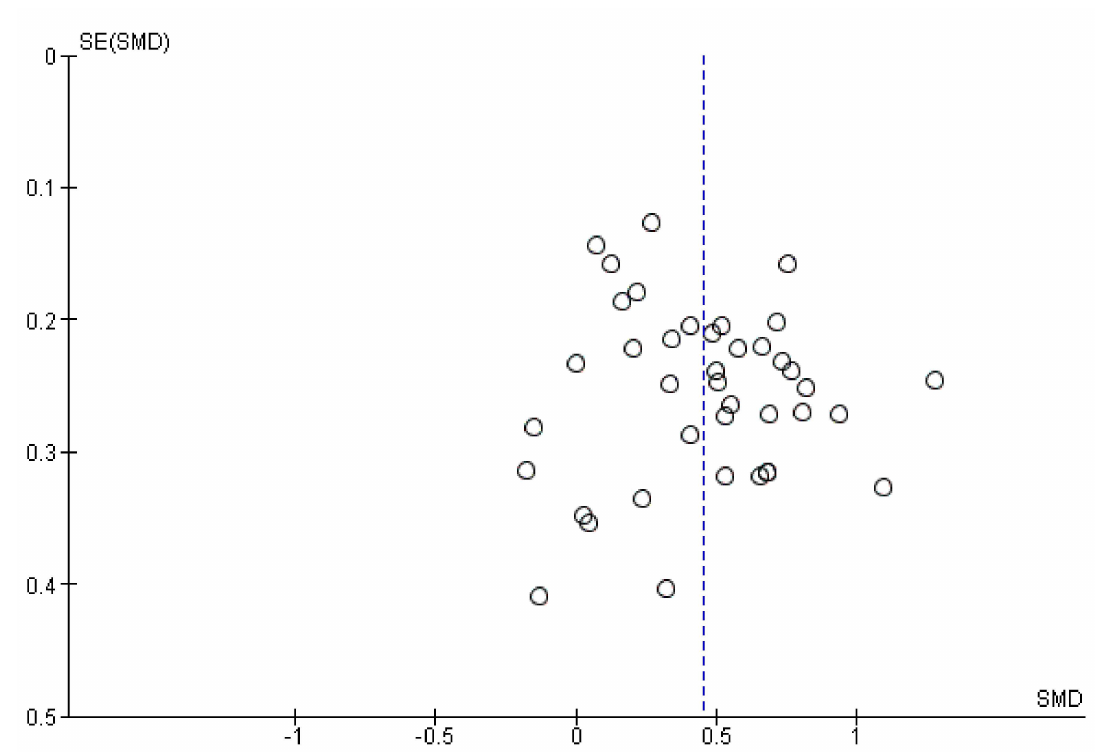
Figure 3. Funnel plot of studies assessing the level of risk taking of adults with AUD compared to control participants included in the global meta-analysis. Note: The circles represent the individual studies included in the global meta-analysis, the blue line represents the overall effect (pooled Hedges’ g = 0.45). An asymmetric funnel plot indicates publication bias. Abbreviations (in alphabetical order) : SE = Standard Error. SMD = Standardized Mean